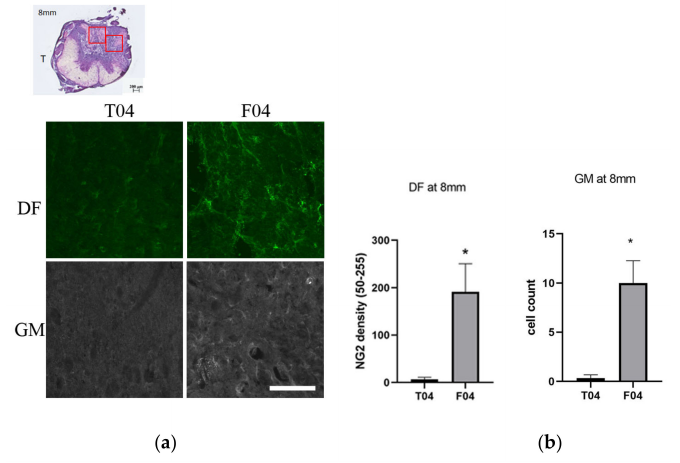
Figure 16. NG2+ cells in the grey matter (dorsal horn) and in the dorsal funiculus. ( a ) At distances ranging from 8 mm from the trauma center, F4 rats had more NG2+ cells compared to T4 rats, in